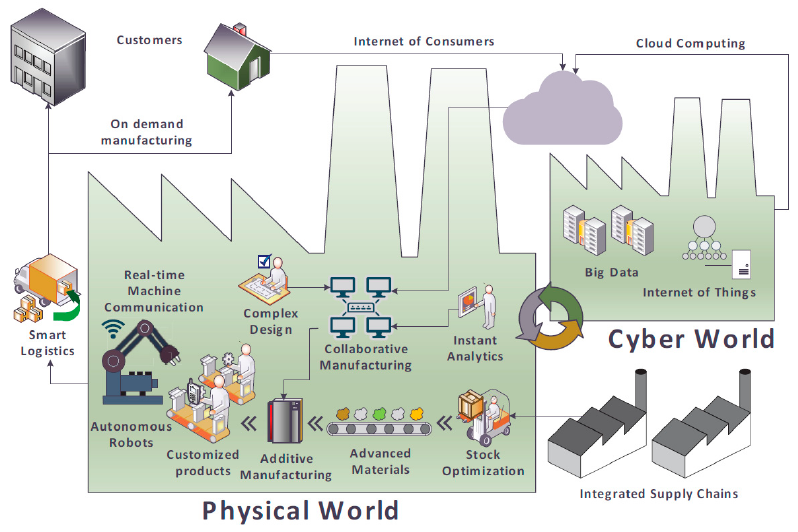
Figure 1. A schematic of smart manufacturing components in Industry 4.0 [4].